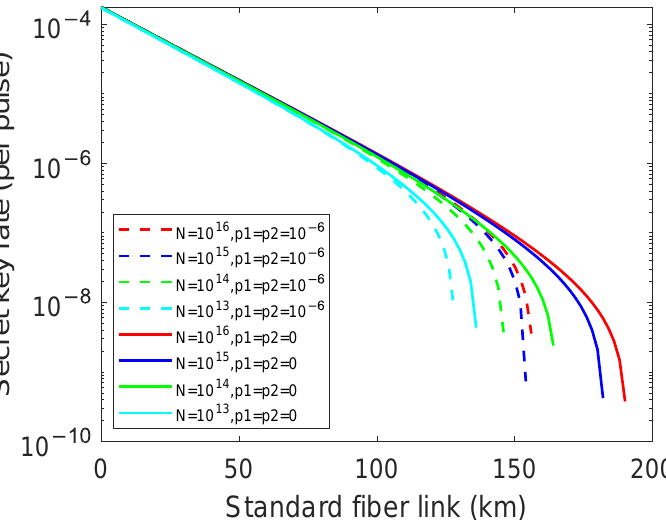
Figure 2. (Color online) The secret key rates (per pulse) in logarithmic scale versus transmission distance between Alice and Bob with weak randomness parameters p 1 = p 2 = 0,10 − 6 for different N = 10 x ( x = 13,14,15,16 ) (curves from left to right). The dashed lines are results of p 1 = p 2 = 10 − 6 for different N , and the solid lines are the results of p 1 = p 2 = 0 for different N